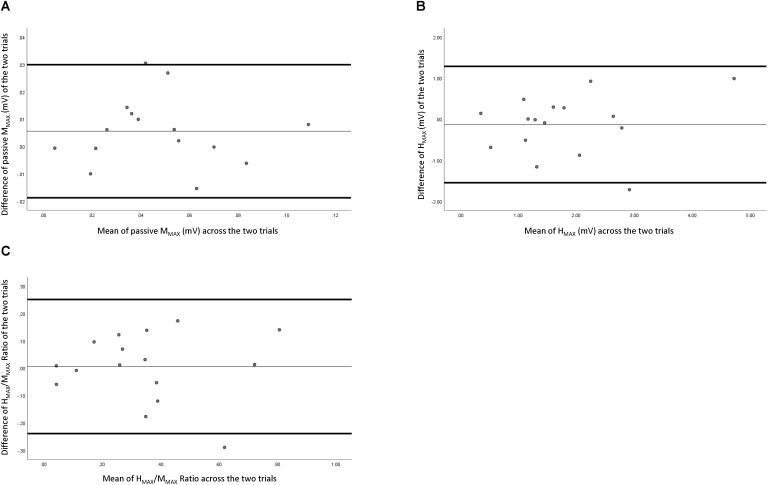
Bland–Altman plot of peripheral measures across the two testing sessions. (A) Resting maximal compound wave, (B) maximal Hoffman reflex, and (C) maximal Hoffman reflex normalized with maximal compound wave.